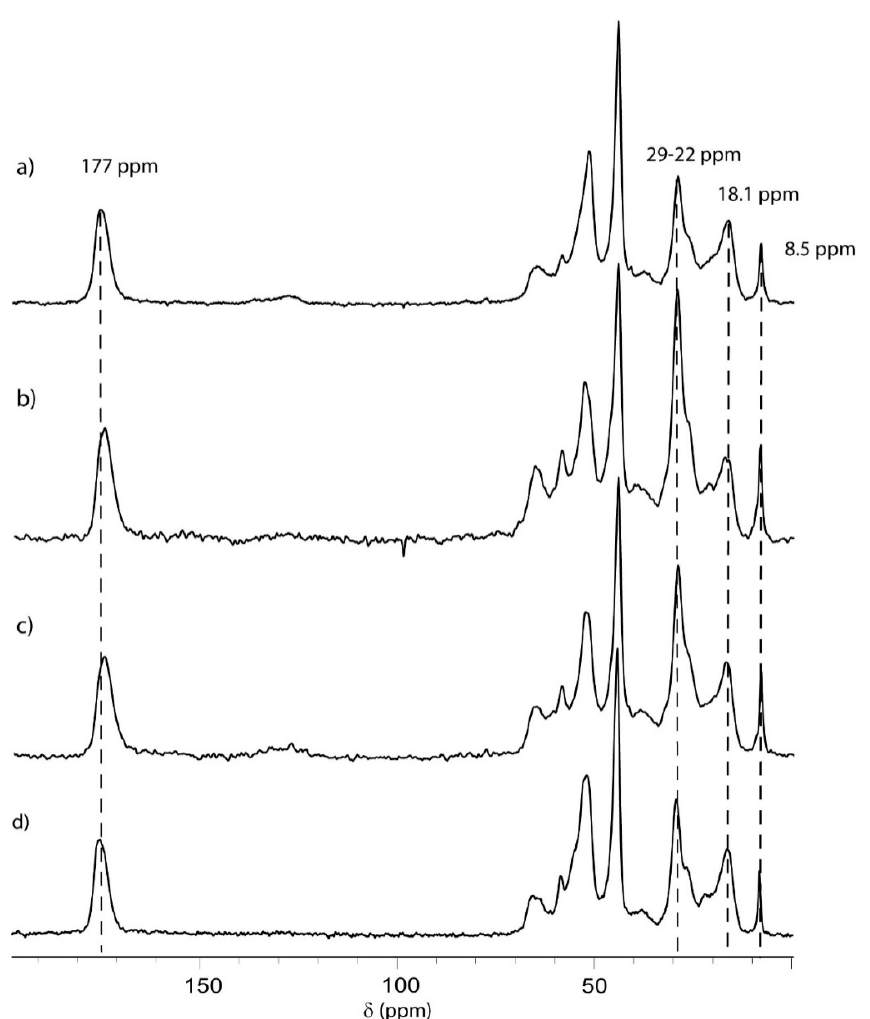
Figure 7. 13 C magic angle spinning nuclear magnetic resonance (MAS-NMR) of the analyzed samples: ( a ) CRP-PBM-9 (material obtained after CRP of PBM for 9 min followed by UV-LED curing with 5 w% Irgacure 184 as photo-initiator); ( b ) UV-LED-1.8 (material obtained after polymerization of the PBM with UV-LED using 1.8 w% Irgacure 184 as photo-initiator); ( c ) UV-LED-5 (material obtained after polymerization of the PBM with UV-LED using 5 w% Irgacure 184 as photo-initiator); and ( d ) REDOX-BPM (material obtained after redox polymerization of the PBM for 5.5 min) . In all samples, the two resonances at 8.5 ppm and between 22–29 ppm are uniquely attributed